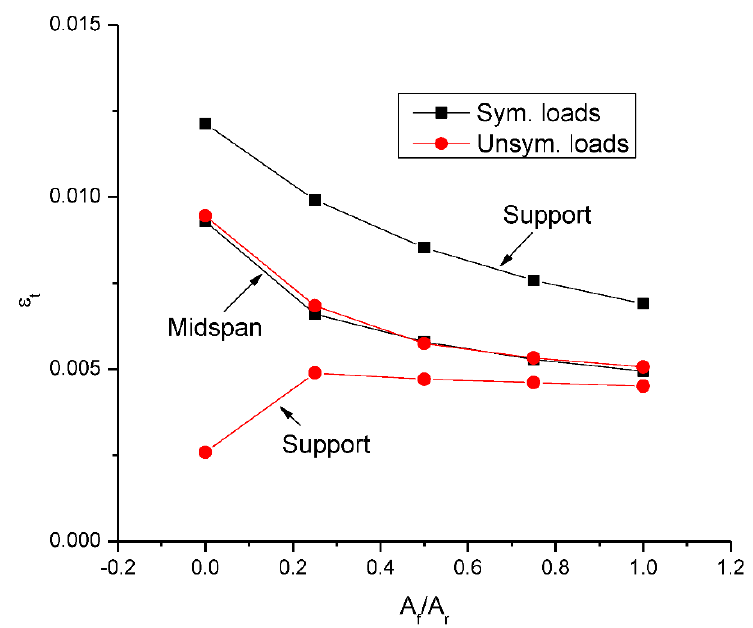
Figure 11. Change in ultimate strain in tensile bars ( ε t ) with the hybrid level.